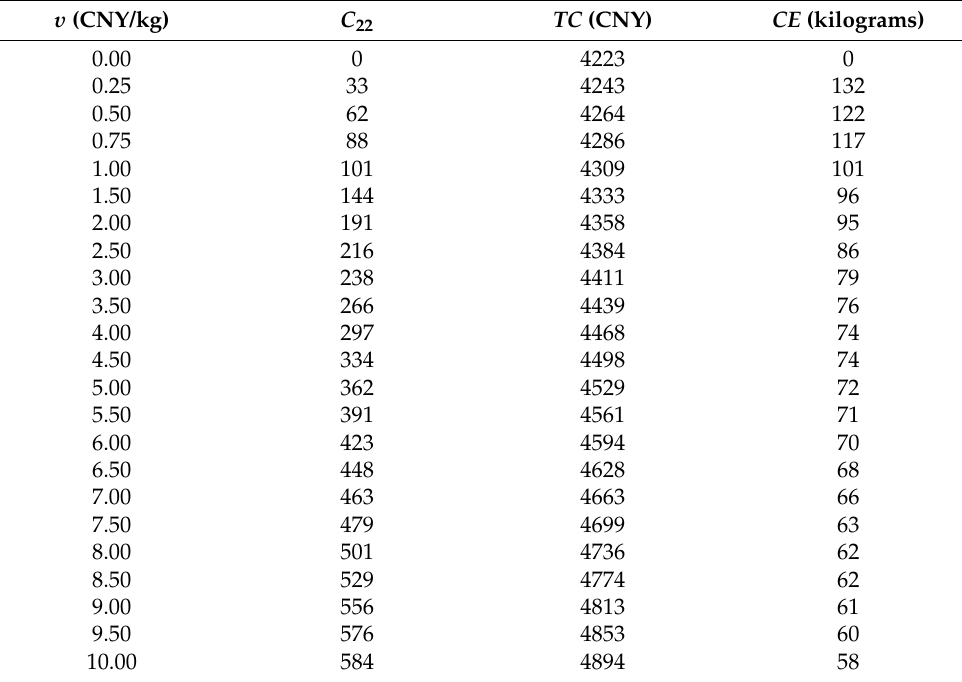
Table 2. Experimental results under different carbon tax